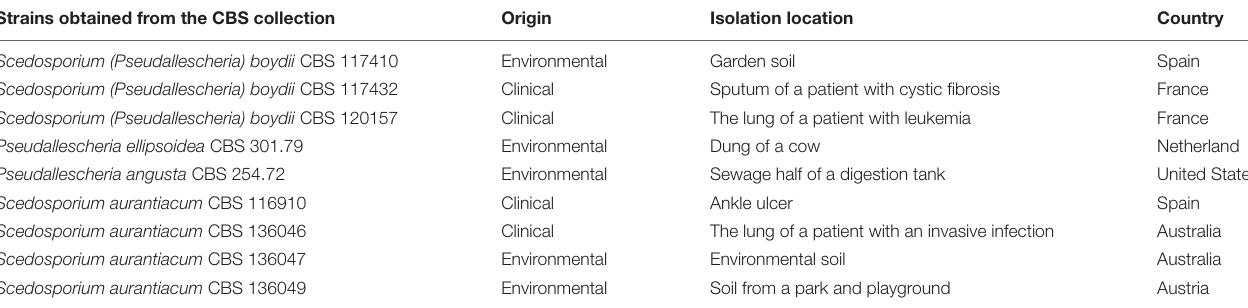
TABLE 1 | The strains used in this